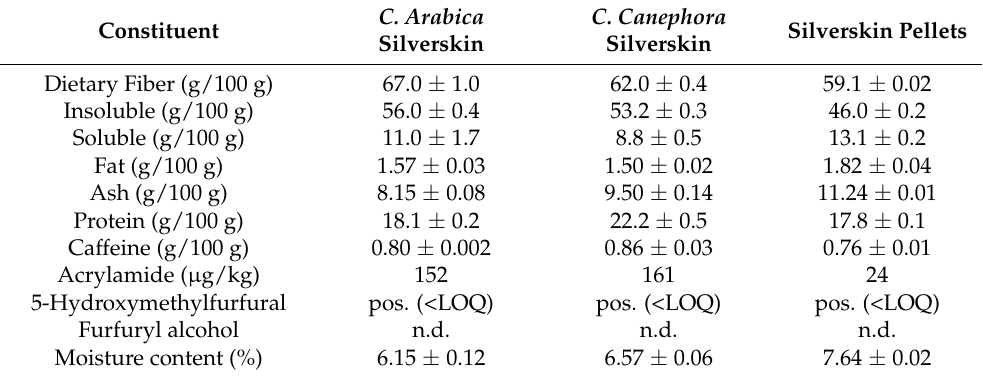
Table 2. Chemical composition of coffee silverskin from Coffea arabica and Coffea canephora as well as coffee silverskin pellets based on dry material (reprinted with permission from Gottstein et al.